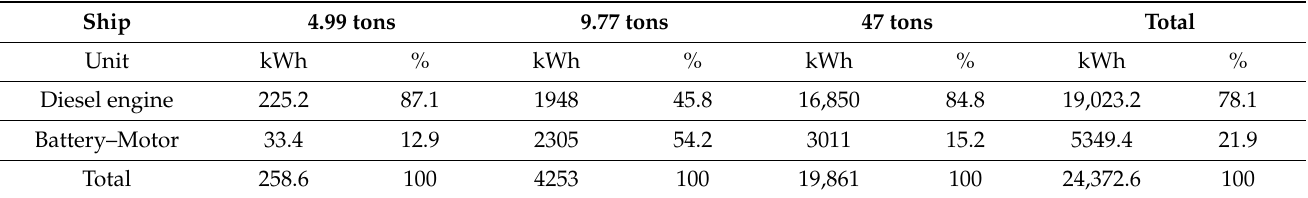
Table 4. Output of proposed battery hybrid fishing boats with ECMS control in idling and fishing.